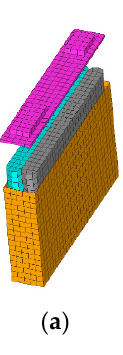
Figure 7. The finite element model of the prismatic cell: ( a ) The structure of the aluminum shell was considered; and ( b ) the structure of the aluminum shell was not considered.